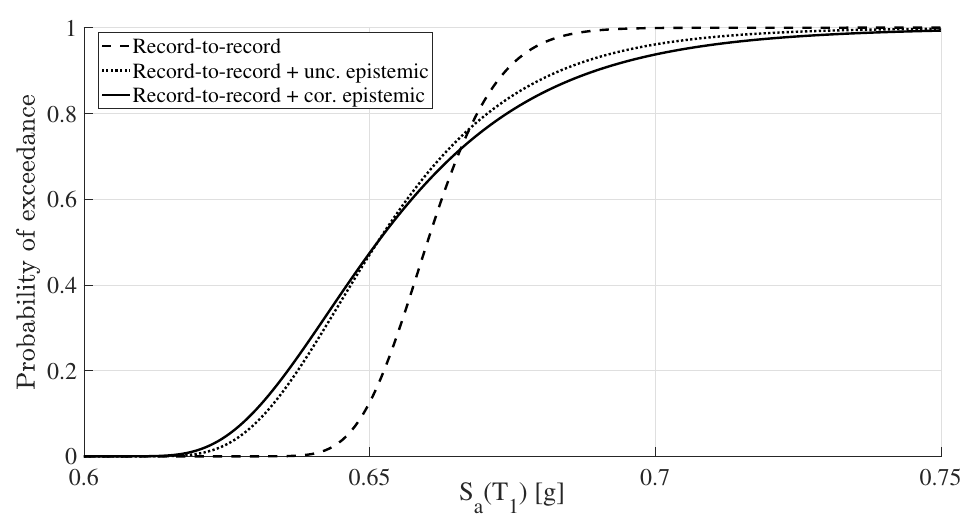
Figure 8. Collapse fragility